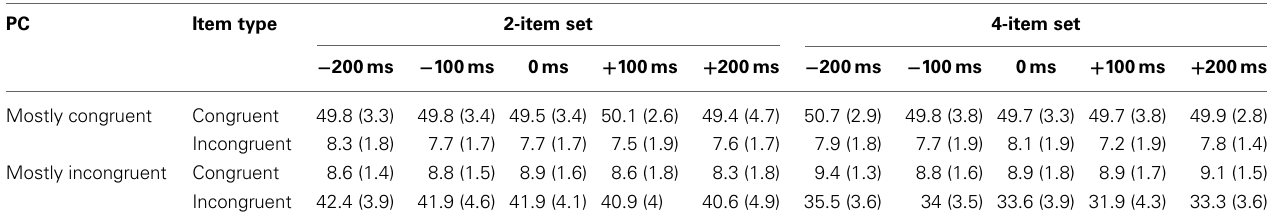
Table 4 | Average number of correct RTs per cell in Experiment 1, after the exclusion of scratch trials, trials with RTs 3 SDs above (or below) the mean, errors, and trials sharing any variety of stimulus- and response-features with the previous